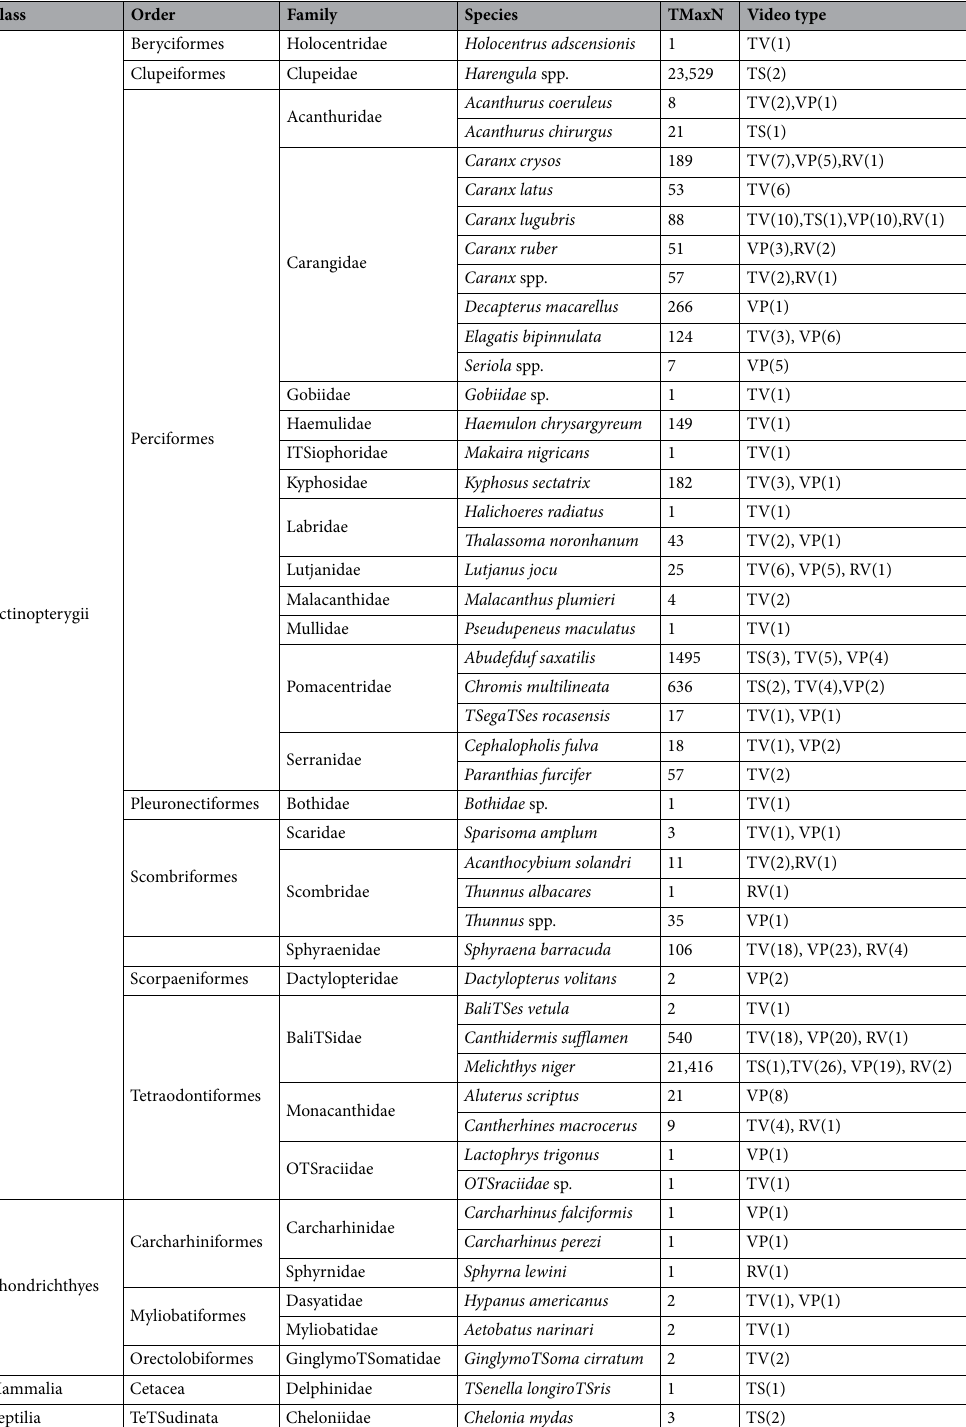
Table 3. List of species observed in video footages. TMaxN sum of the maximum number of individuals of a given species present in a single video frame, TV towed video, TS transducer support, VP vertical profile, RV ROV. The numbers in parenthesis associated to video types indicates the number of videos in which each species was